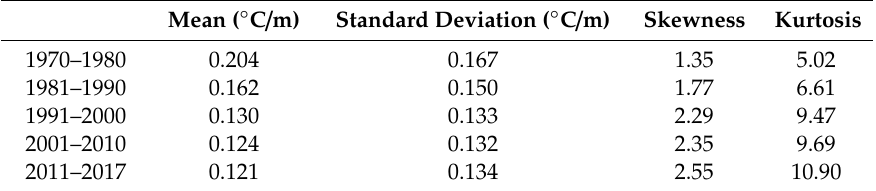
Table 3. Decadal variation of statistical characteristics of the global thermocline gradient ( G ) in comparison to